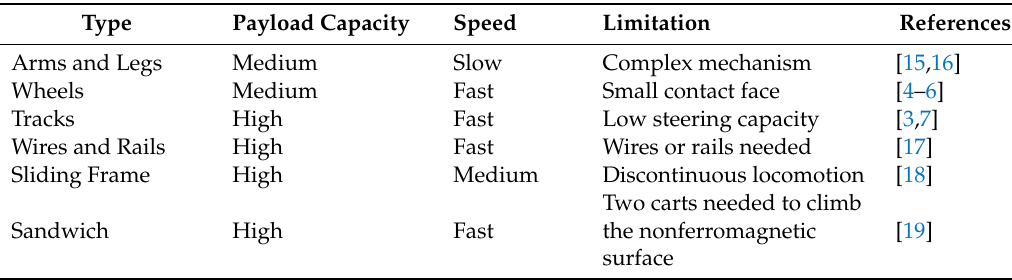
Table 3. Comparison of locomotion